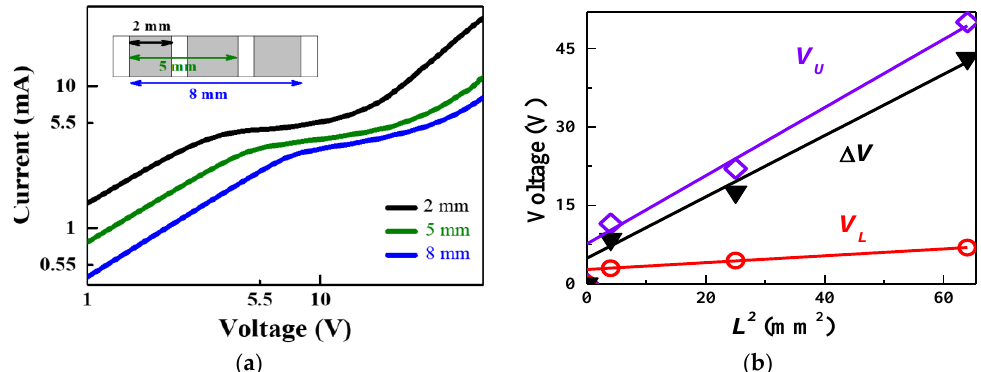
Figure 2. Electrode spacing dependence of two critical voltages. ( a ) Black, green, and blue curves are I–V curves with electrode spacing L of 2, 5, and 8 mm measured at room temperature for device 0129-7#. The inserted figure at the left top is the schematic setup, in which the white squares represent indium electrodes. ( b ) The lower and upper critical voltages, V L and V U , as well as their difference and Δ V = V U − V L , versus the square of electrode spacing L 2 . Red, purple, and black data illustrate V L , V U , and Δ V respectively. All of them exhibit a linear relationship with L 2 .